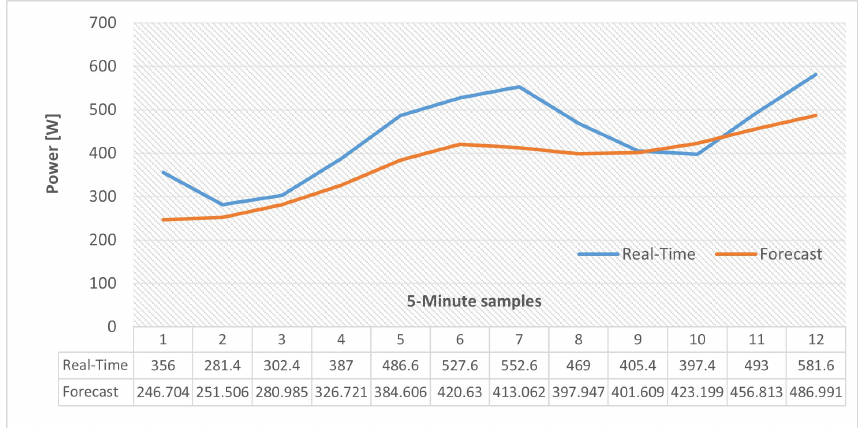
Figure 13. Internal power excess/deficit inside the MG (One hour